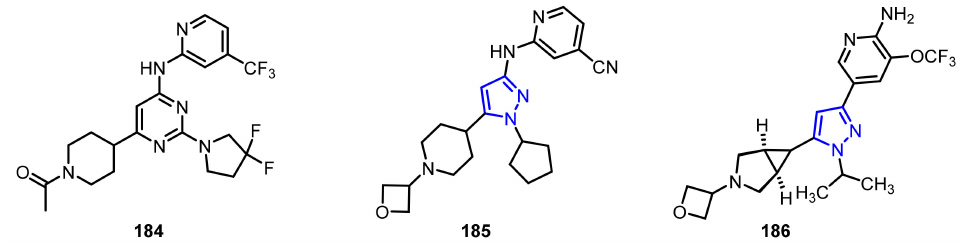
Figure 14. Chemical structures of pyrazole-containing dual leucine zipper kinase (DLK)